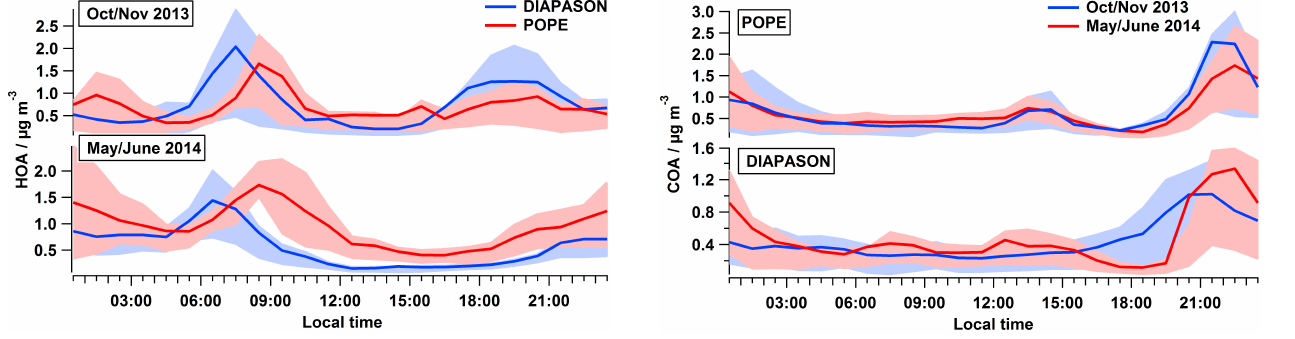
Figure 11. Diurnal cycles of COA mass concentrations observed in central Rome (top: POPE) and the suburban site (bottom: DIA- PASON) during both seasons. Mean concentrations (traces) and the corresponding 25th and 75th percentiles (shaded areas) are